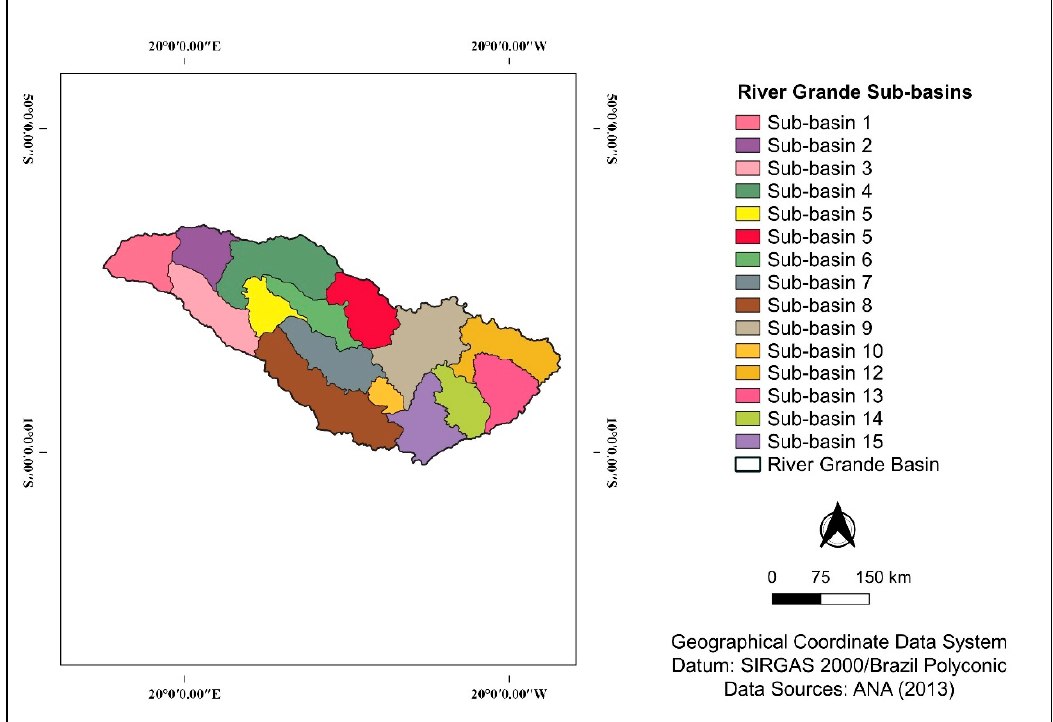
Figure 2. Rio Grande Hydrographic Basin compartmentalized into sub-basins.